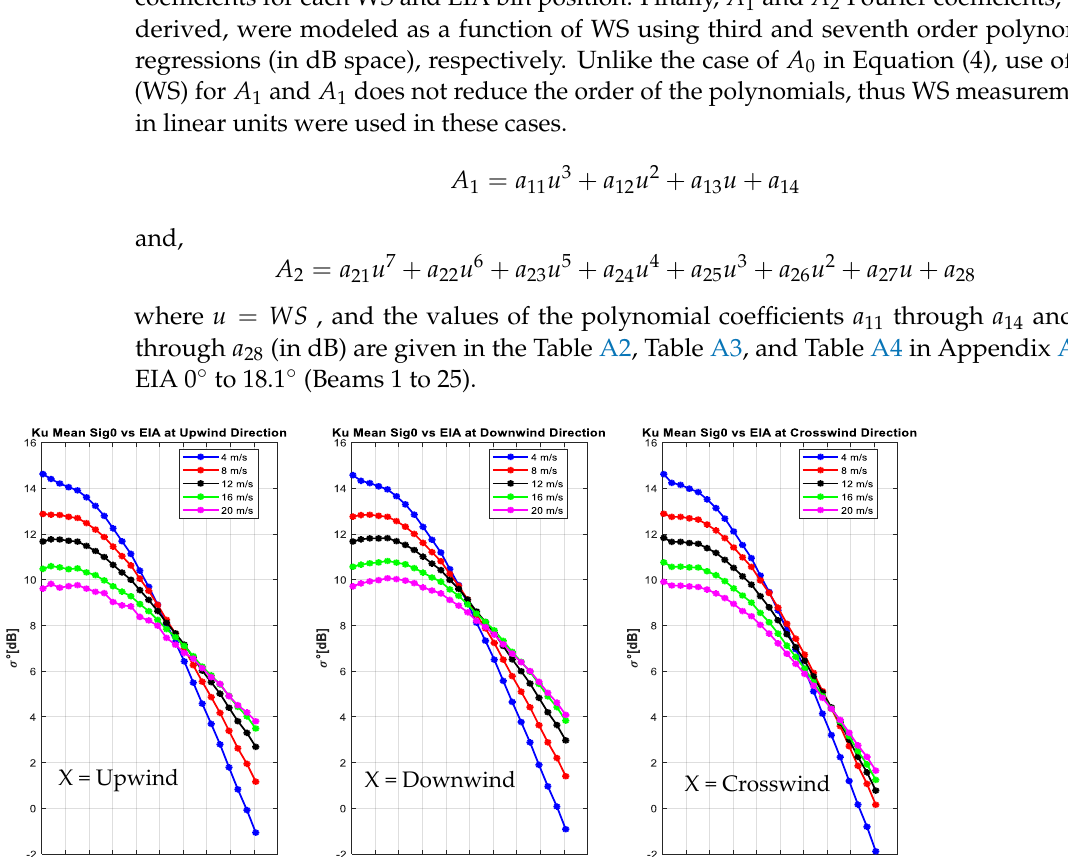
Figure 10. Mean value of binned σ 0 (in dB) at KuPR as a function of earth incidence angle θ , for different relative wind directions: upwind ( leftmost ), downwind ( middle ), and crosswind ( rightmost ).